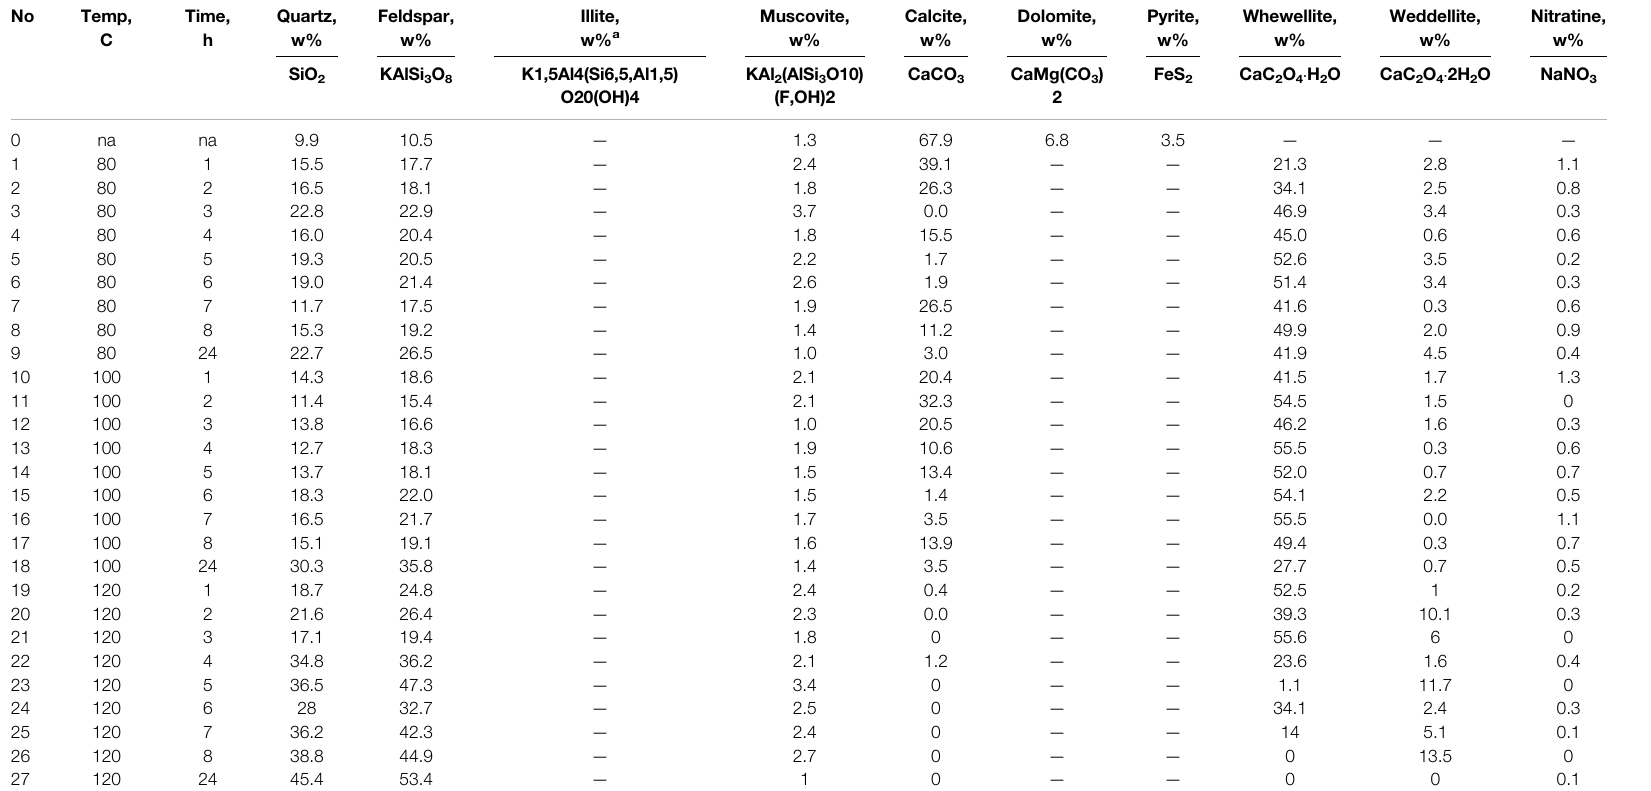
TABLE 2 | Mineral composition of solid residue according to PXRD